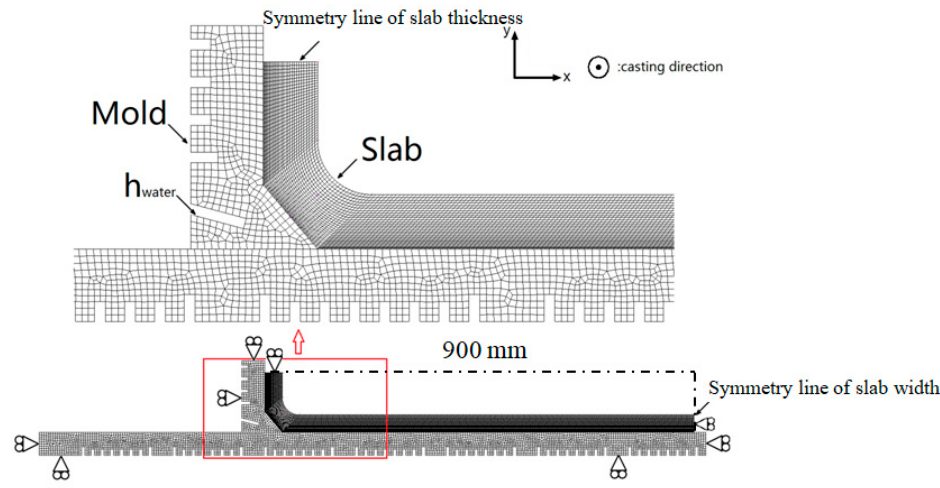
Figure 2. Calculation domain and mesh division of the model.